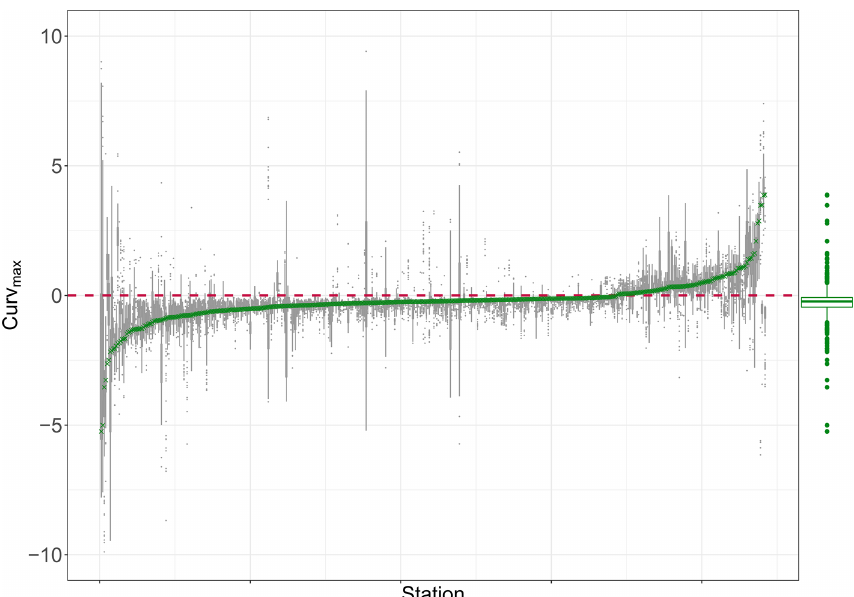
Figure B4. Curv max of nitrate log (C) –log (Q) data for 444 French monitoring stations arranged from left to right with increasing Curv max (green crosses). For a given station, the gray boxplot represents the temporal robustness of this metric by subsampling 100 times from the original time series. The green boxplot indicates the range and distribution of all observed station Curv max values.